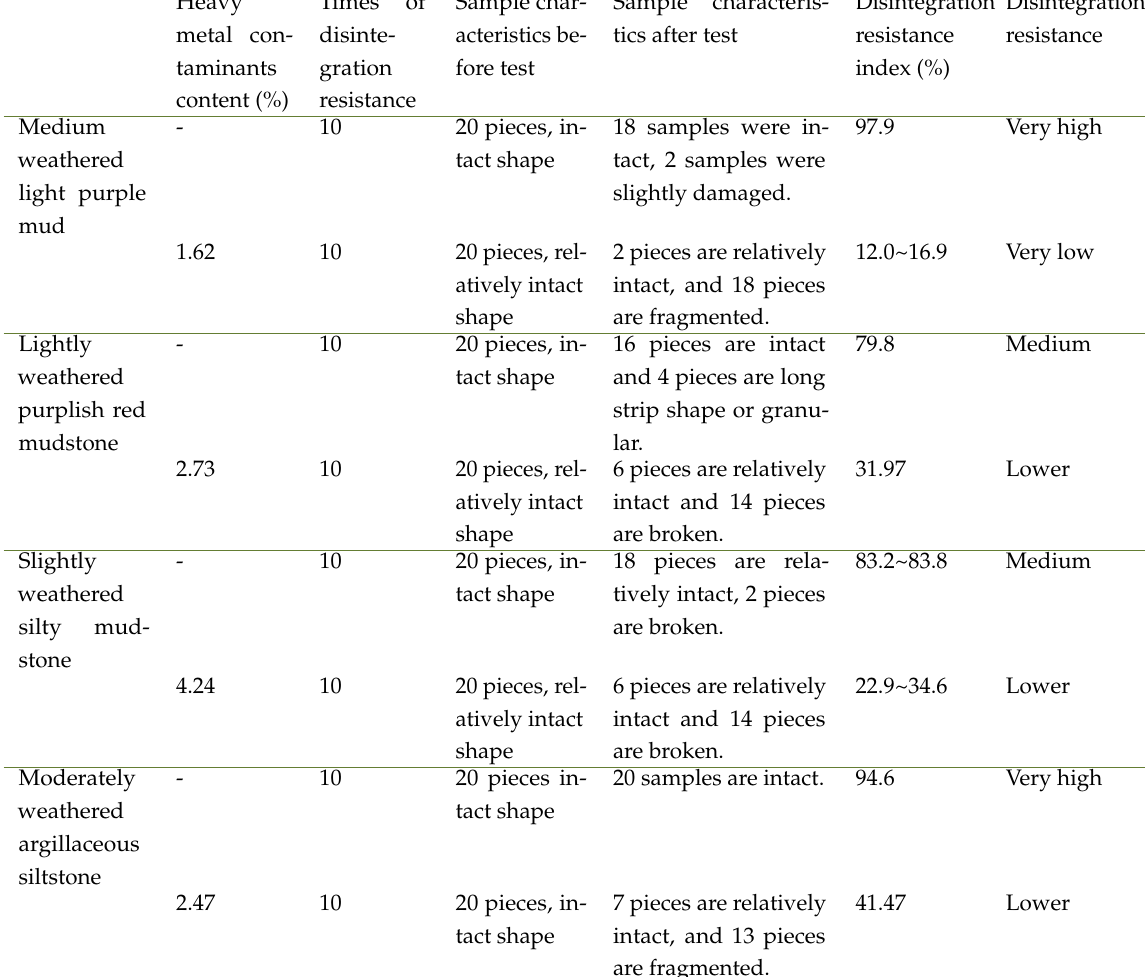
Table 3. The results of disintegration resistance